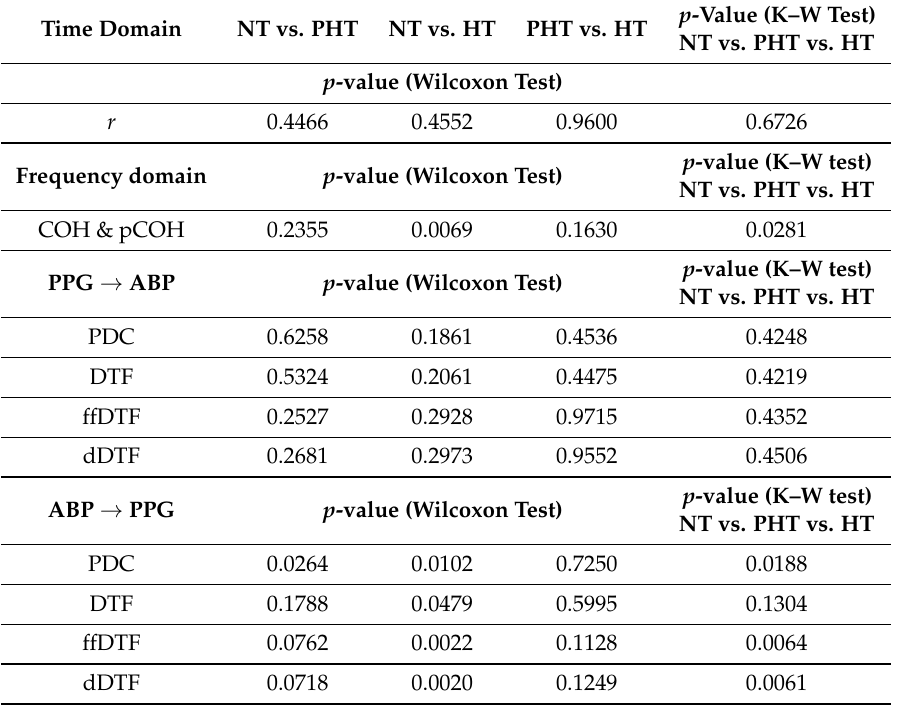
Table 2. Out-phase statistical separability results. Abbreviations: NT, normotensive; PHT, Prehypertensive; HT, Hypertensive; r , Pearson’s correlation coefficient; COH, Coherence; pCOH, Partial coherence; PDC, Partial directed coherence; DTF, Directed transfer function; dDTF, Direct directed transfer function; ffDTF, Full frequency directed transfer function; K-W test, Kruskal–Wallis